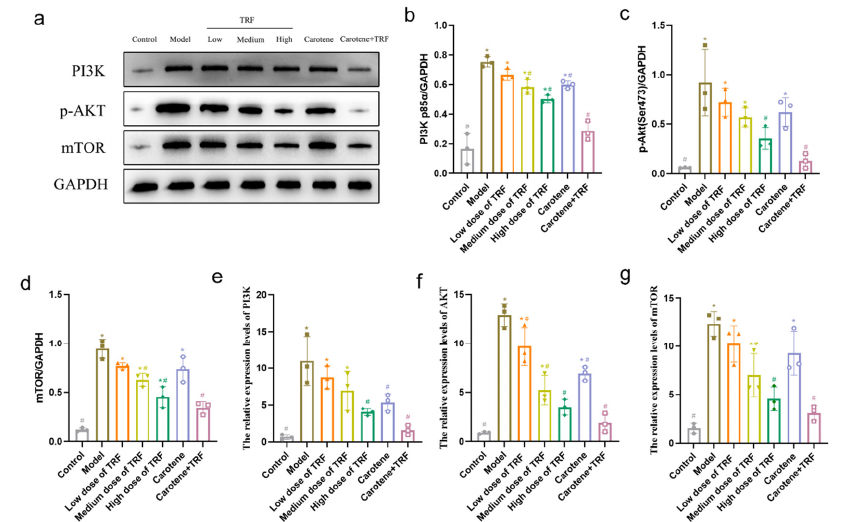
Figure 7. TRF and carotene protected against pulmonary fibrosis via the inhibition of the PI3K/AKT/mTOR signaling pathway: ( a – d ) TRF and carotene decreased the expression of fibrosis proteins induced by BLM in SD rats. The protein expressions of ( b ) PI3K, ( c ) p-AKT, and ( d ) mTOR in the lung samples were examined by Western blotting analysis, n = 3: ( e – g ) representative statistical analyses of ( e ) PI3K, ( f ) AKT, and ( g ) mTOR mRNA by RT-qPCR, n = 3. Note: compared with CON group, # represents p < 0.05; compared with MOD group, * represents p < 0.05.